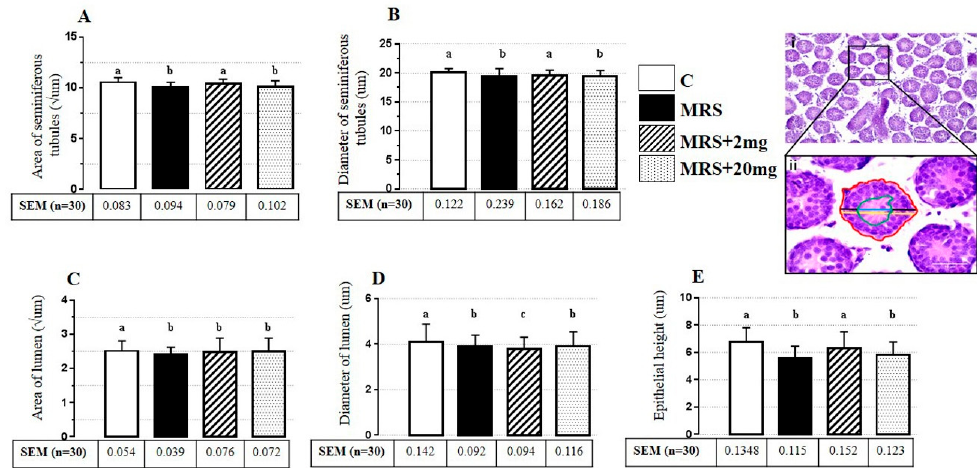
Figure 1. Photomicrograph of one week old mouse testis showing histologic figure ( i ) and measurements ( ii ). Scale bar 10 µ m. Area of seminiferous tubules (red), diameter of seminiferous tubules (yellow), area of the lumen (green), diameter of the lumen (blue), epithelial height (black). Histologic measurements of 7 days old mice pups. ( A ) The area and ( B ) the diameter of seminiferous tubules significantly 2 mg / kg group in both graph pictures, while there was no curative significant e ff ect of 2 mg / kg on ( C )